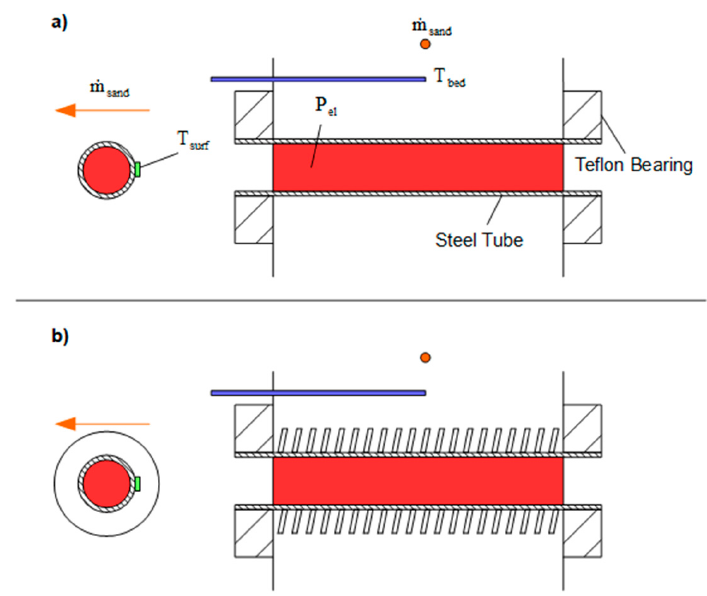
Figure 6. TRINI test tube configuration: ( a ) Plain tube; ( b ) Helically finned tube.